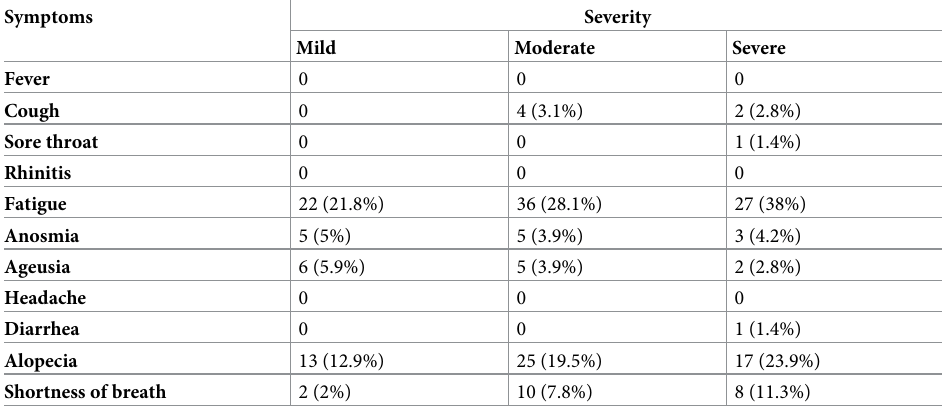
Table 3. Severity of symptoms at third